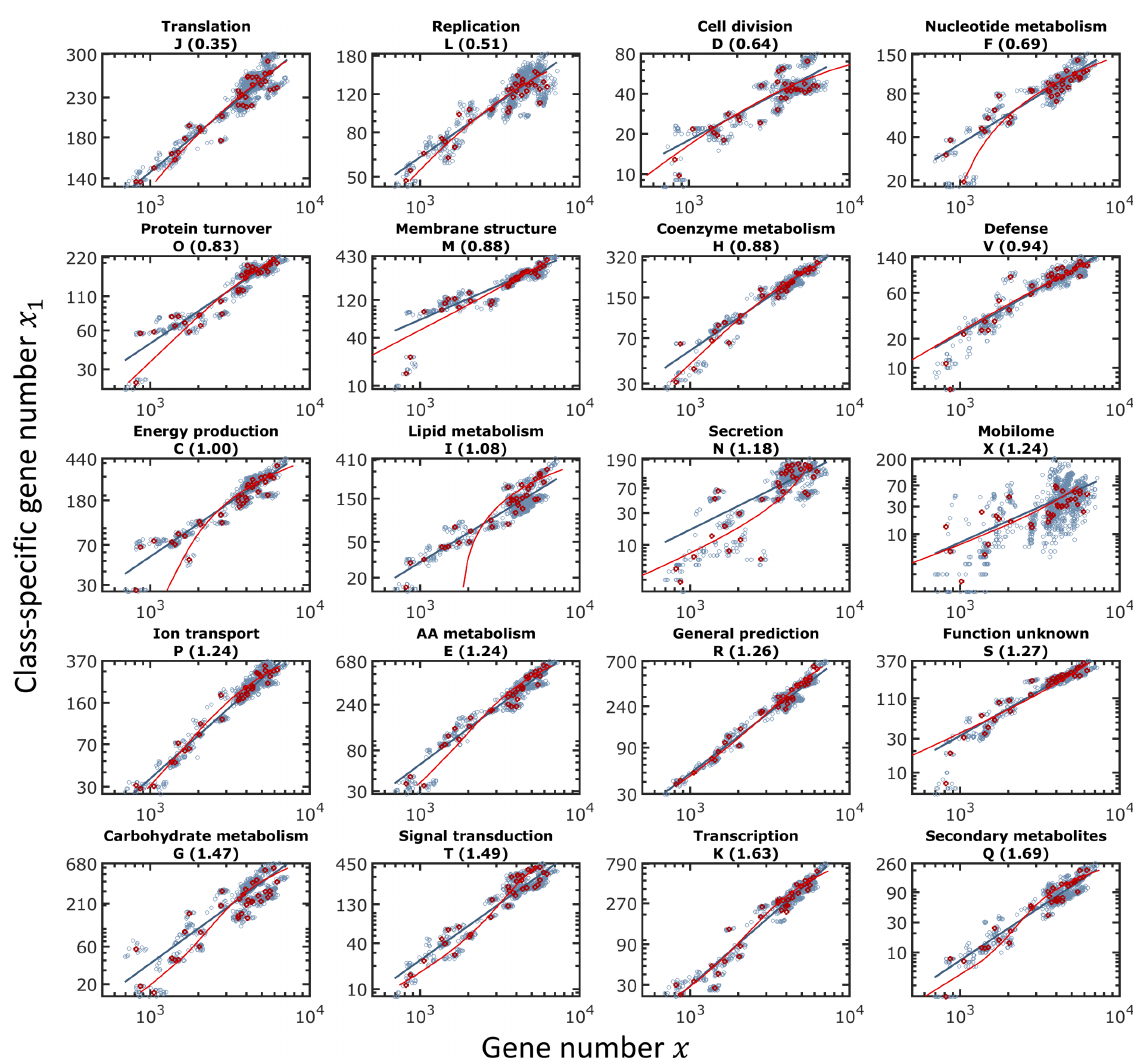
FIG. 1. The scaling laws for all functional classes of the COGs. The number of genes in each functional class scales with the total number of genes, and the scaling exponents substantially differ between the classes. The number of genes in a given COG category is plotted against the total number of genes, together with a power-law fit and model fit, as given by Eq. (2). Each gray point represents one genome from the analyzed set of 1490 genomes. The scaling is fitted to a power law which is indicated by a solid gray line. The fitted scaling exponent is indicated in parentheses. Red points correspond to the mean values for each ATGC in the dataset, and the model fit of Eq. (2) is shown by the solid red